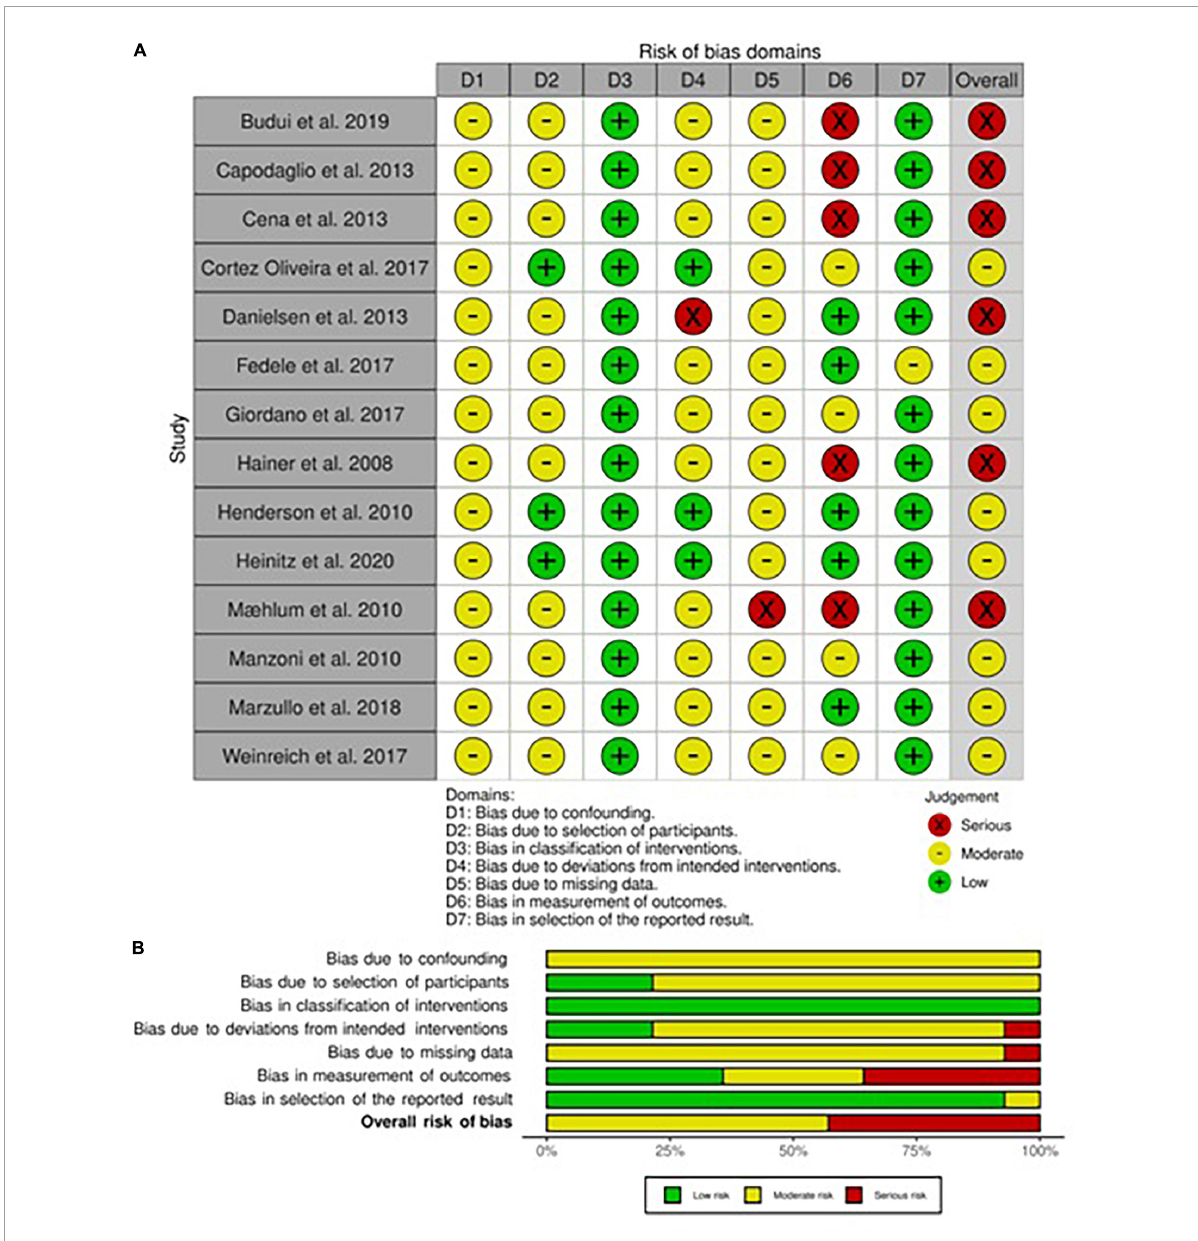
FIGURE2 Risk of bias within longitudinal studies in adults. (A) Traffic light plot and (B) summary plot presenting the risk of bias within the longitudinal studies included in the systematic